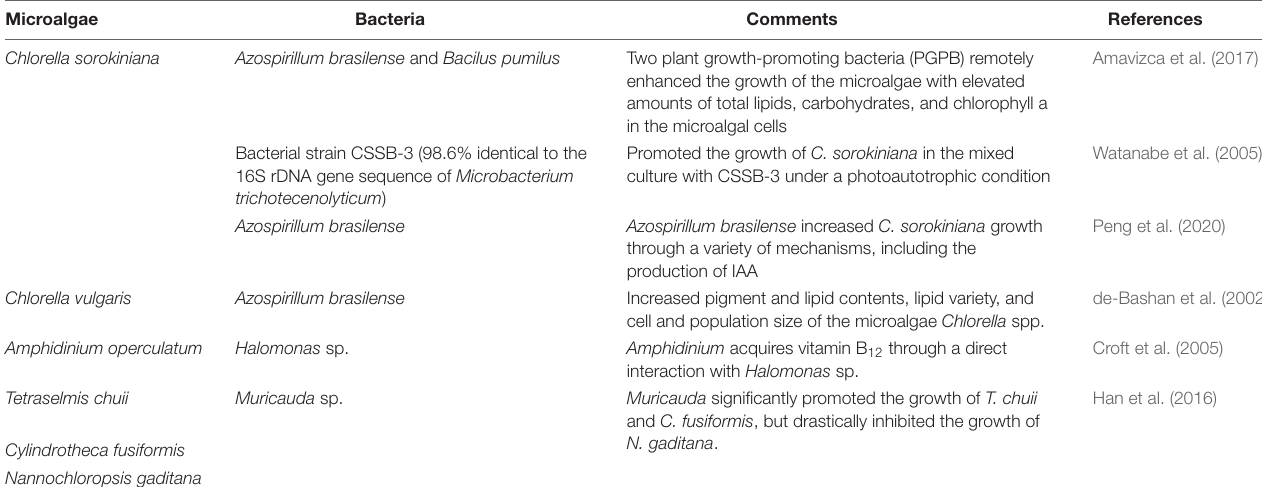
FIGURE 2 | Symbiotic interactions between microalgae and plant growth-promoting bacteria (PGPB) for sustainable cultivation of plants. Microalgae and PGPB in the symbiotic relationship cooperate with each other by efficient exchange of nutrients. Microalgae supply photosynthetic oxygen, organic carbon, calcium carbonate, and 2 3-dihydroxypropane-1-sulfonate (DHPS) to bacteria in exchange for micronutrients (i.e., vitamins) and macronutrients (i.e., nitrogen and phosphorus). Both microalgae and bacteria can enhance plant growth by producing phytohormones and other growth stimulants. Moreover, they are also able to inhibit plant diseases by using their distinct disease-suppressive mechanisms. TABLE 3 | Examples of microalgae–bacteria interactions in co-culture/combination. Microalgae